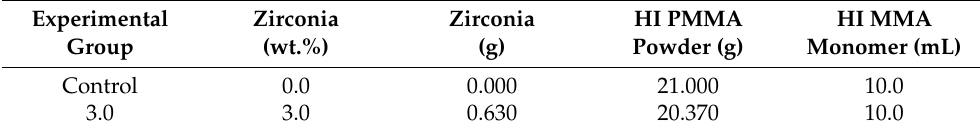
Table 1. Components of the experimental specimens by weight.